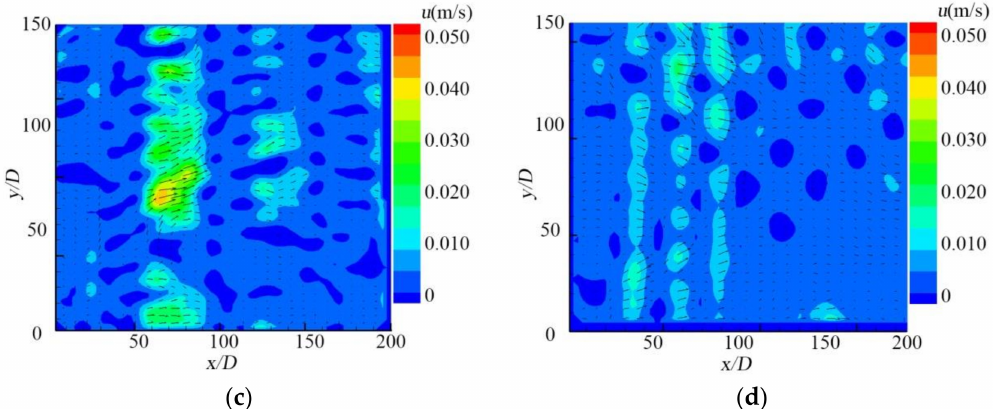
Figure 4. The different flow conditions for the average flow-field distribution of a transverse jet in the horizontal plane z/D = 5. ( a ) vector map of V xy for run V0J1; ( b ) vector map of V xy for run V1J1; ( c ) vector map of V xy for run V2J1; ( d ) vector map of V xy for run V3J1. (Note: Color indicates the speed: blue represents the lowest speed, and red represents the highest